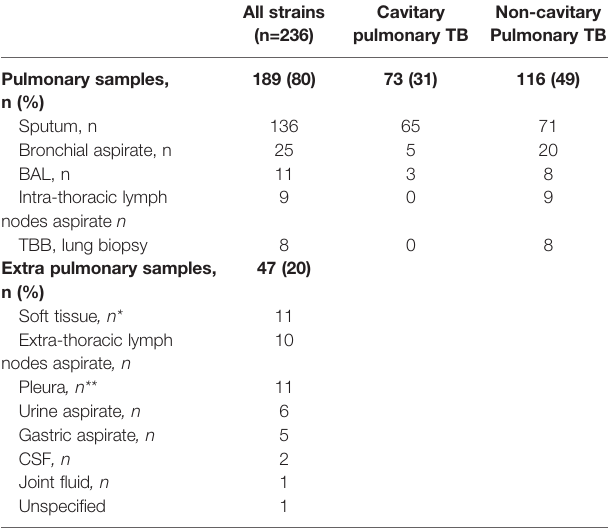
TABLE 2 | Origin of samples (n=236